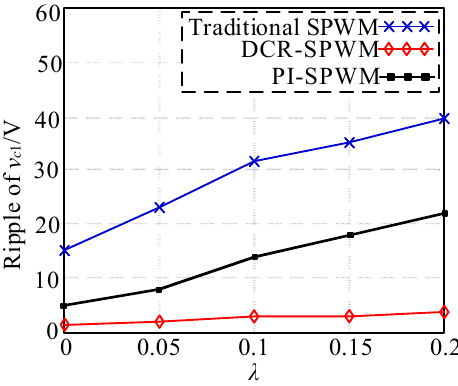
Figure 15. Measured NP voltage ripple.